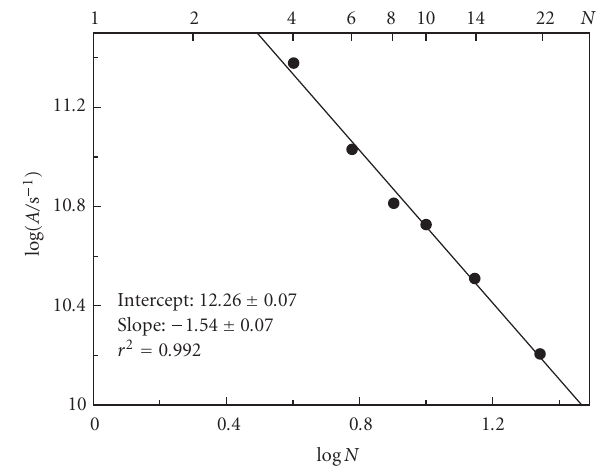
Figure 3: Double logarithmic plot of the pre-exponential factors for loop formation (Table 4) versus the peptide length, taken as the number of intervening amide bonds ( N